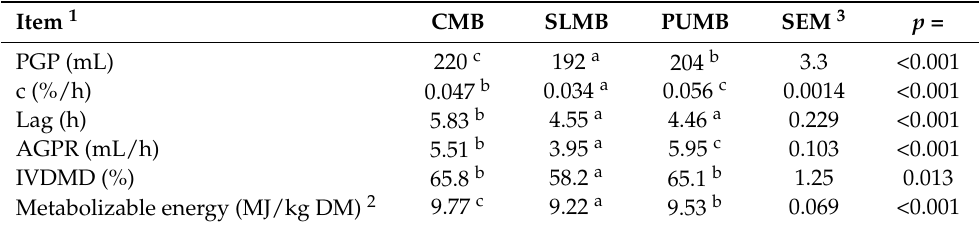
Table 4. Parameters of in vitro gas production kinetics, in vitro dry matter degradability (IVDMD) and estimated metabolizable energy content of multinutrient blocks including no seaweed (Control;